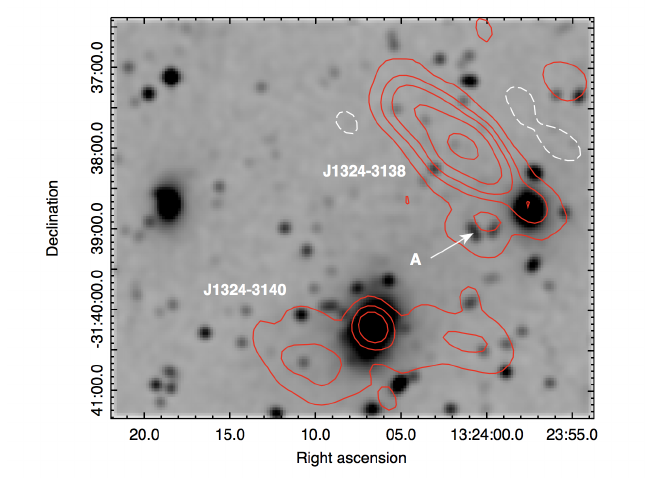
Figure 5. 325 MHz Contours of the central region of A3556 overlaid on DSS2. Contour levels and resolution as in the previous